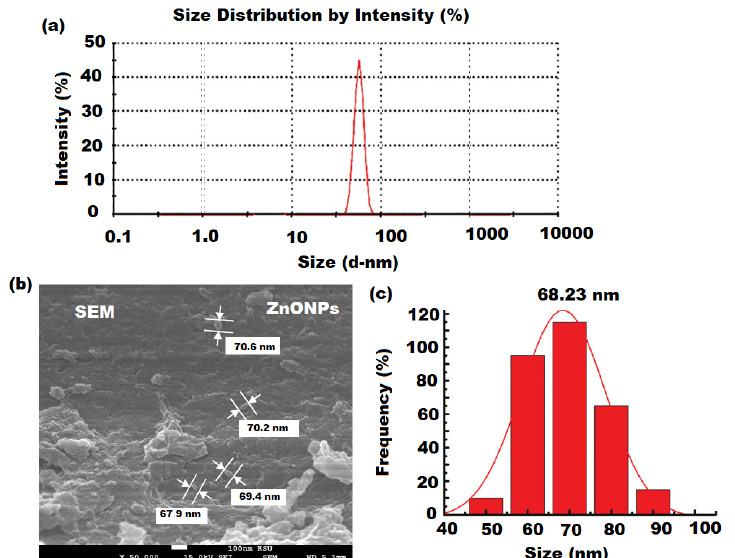
Figure 4. ( a ) DLS analysis ( b ) SEM, and ( c ) particle size distribution of ZnONPs.